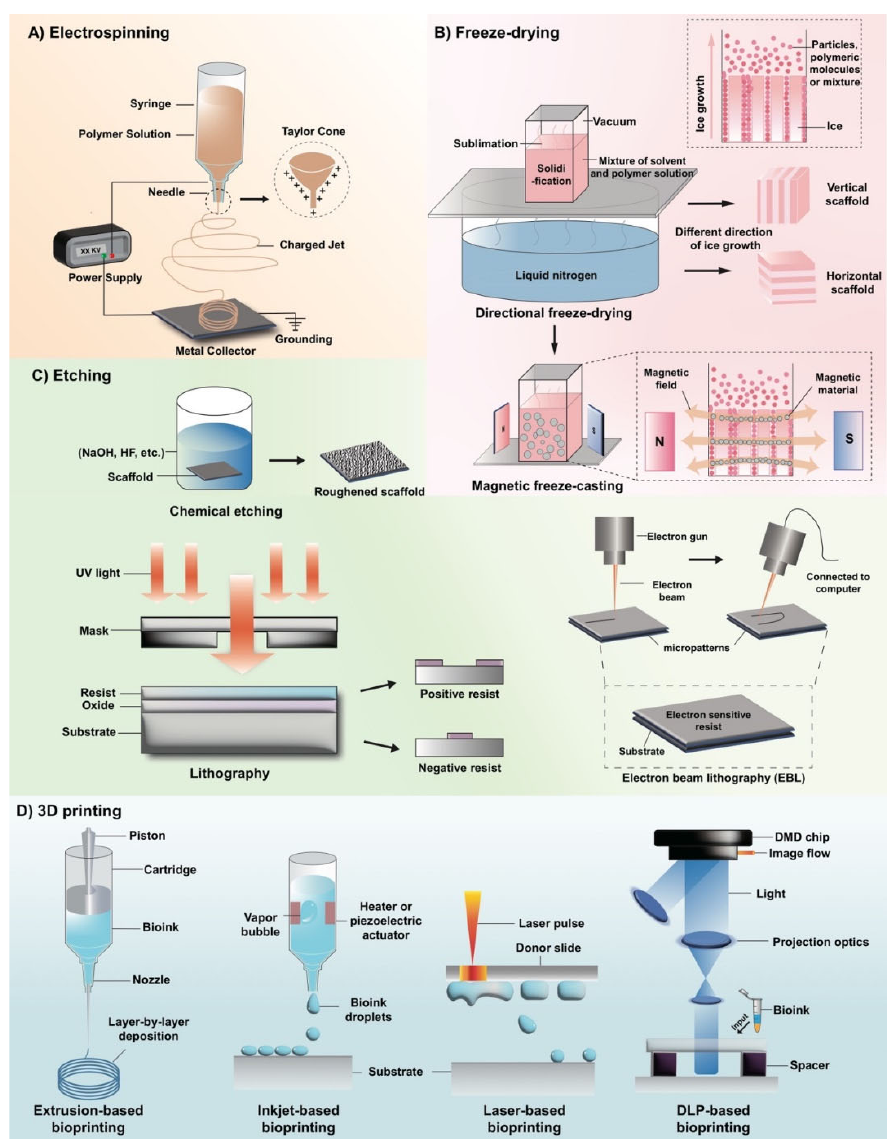
Figure 1. Schematic illustration of the fabrication of scaffolds with different topographies. ( A ) Elec- trospinning; ( B ) directional freeze ‐ drying and magnetic freeze ‐ casting; ( C ) etching; ( D ) 3D printing.